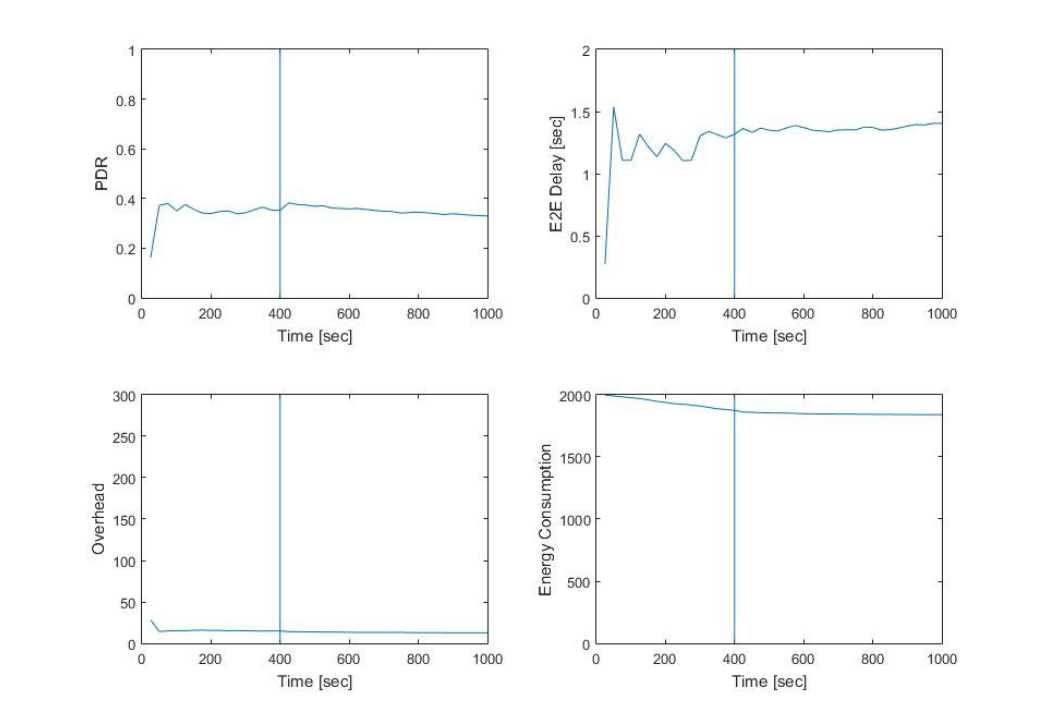
Fig. 3. Evaluation of OLSR protocol based on 10 mobile sensor